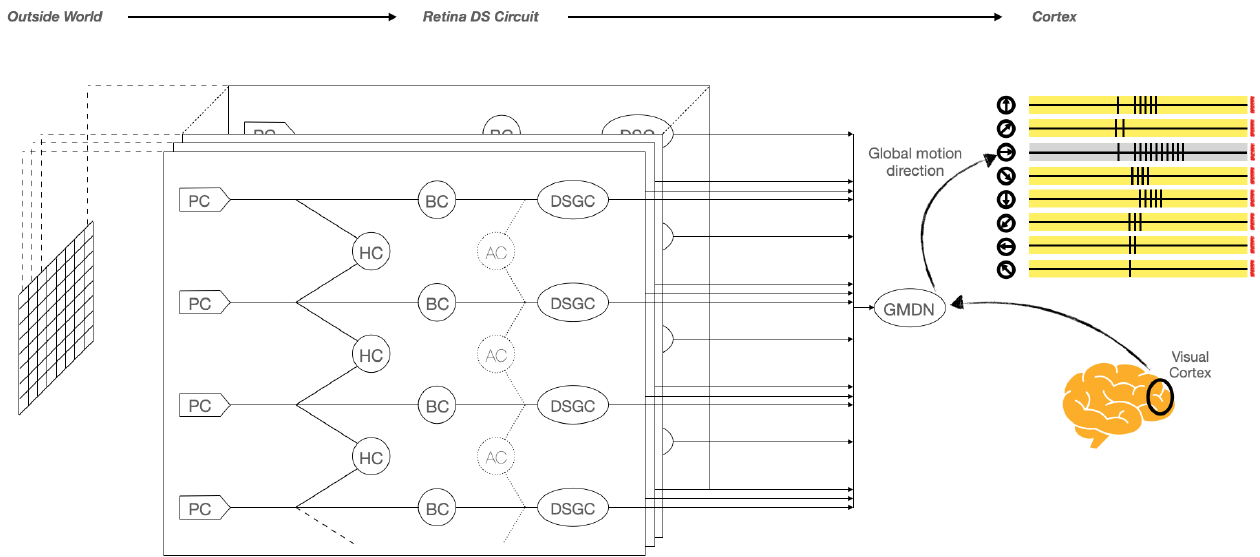
Figure 3. The structure of direction-selective pathway in the visual